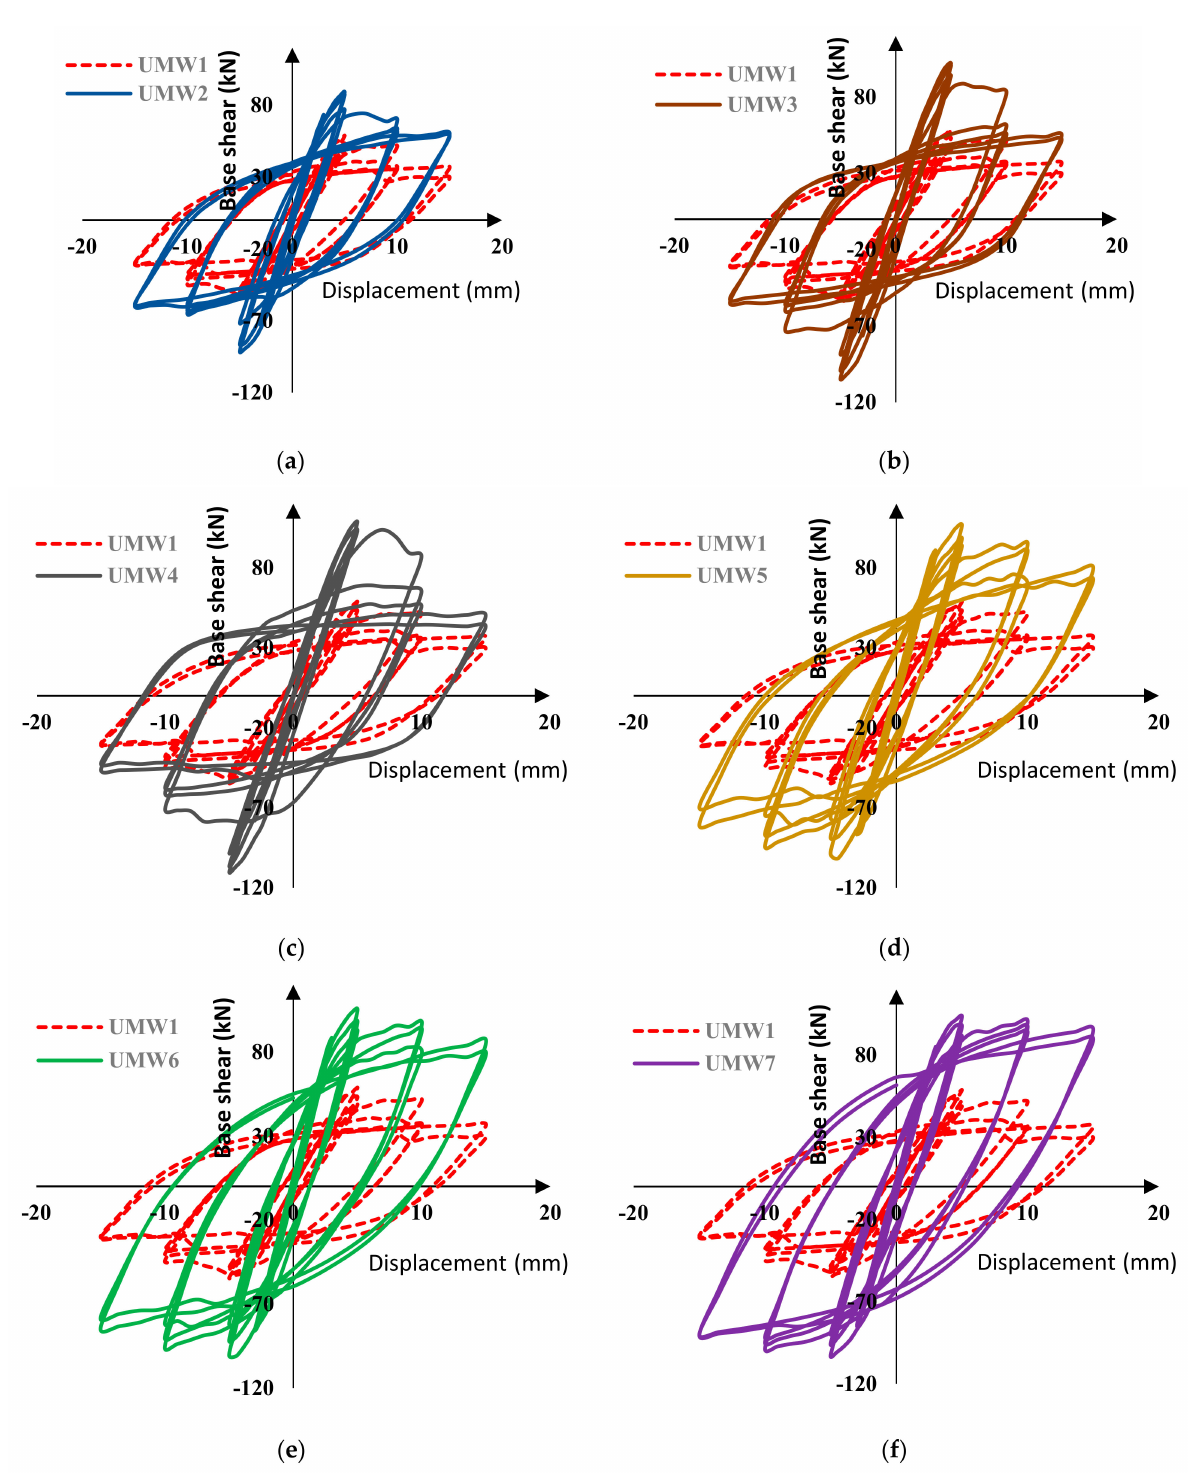
Figure 15. Hysteresis of Fe-SMA reinforced walls, ( a ) UMW2, ( b ) UMW3, ( c ) UMW4, ( d ) UMW5, ( e ) UMW6, and ( f )